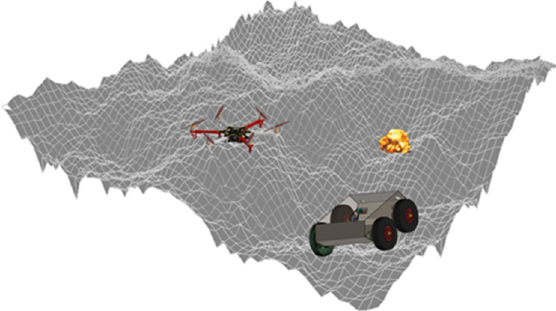
Figure 5. Unmanned autonomous system (UAS) 3D representation.